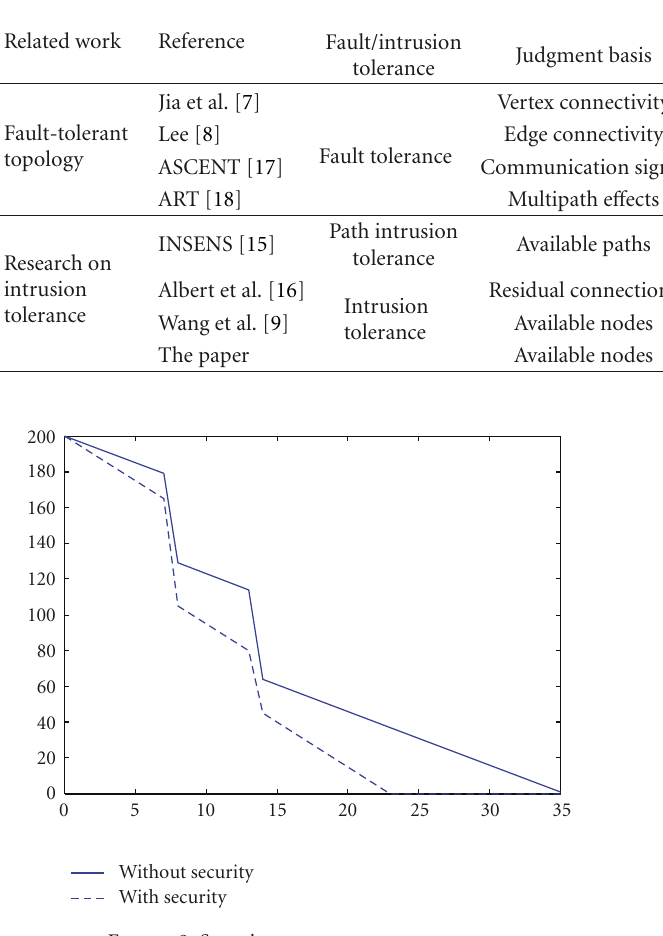
Figure 9: Security operator on rest energy.